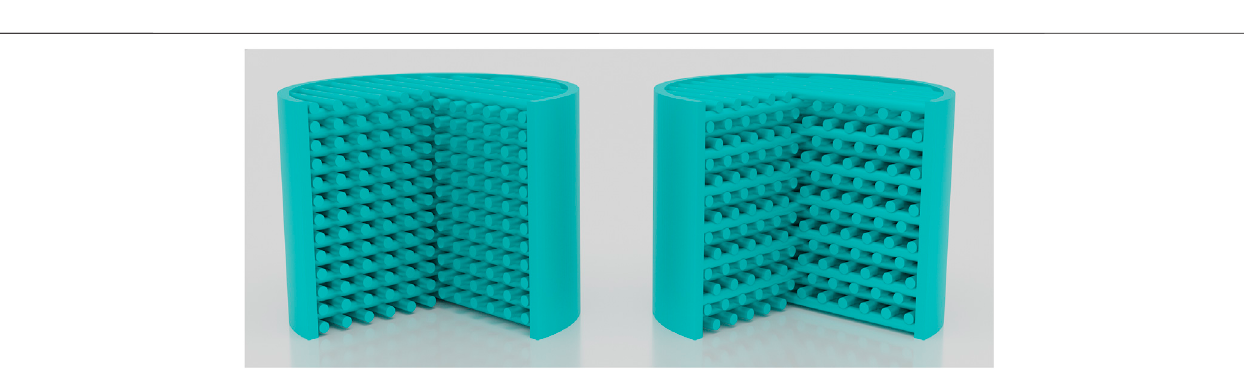
Frontiers in Chemical Engineering |